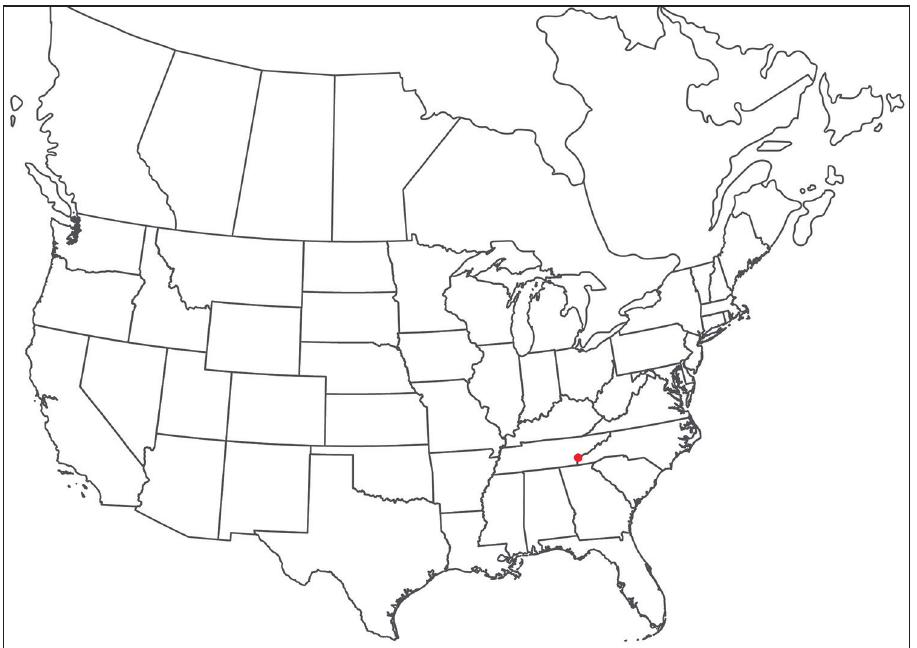
Figure 132. Torrenticola longitibia sp. n.